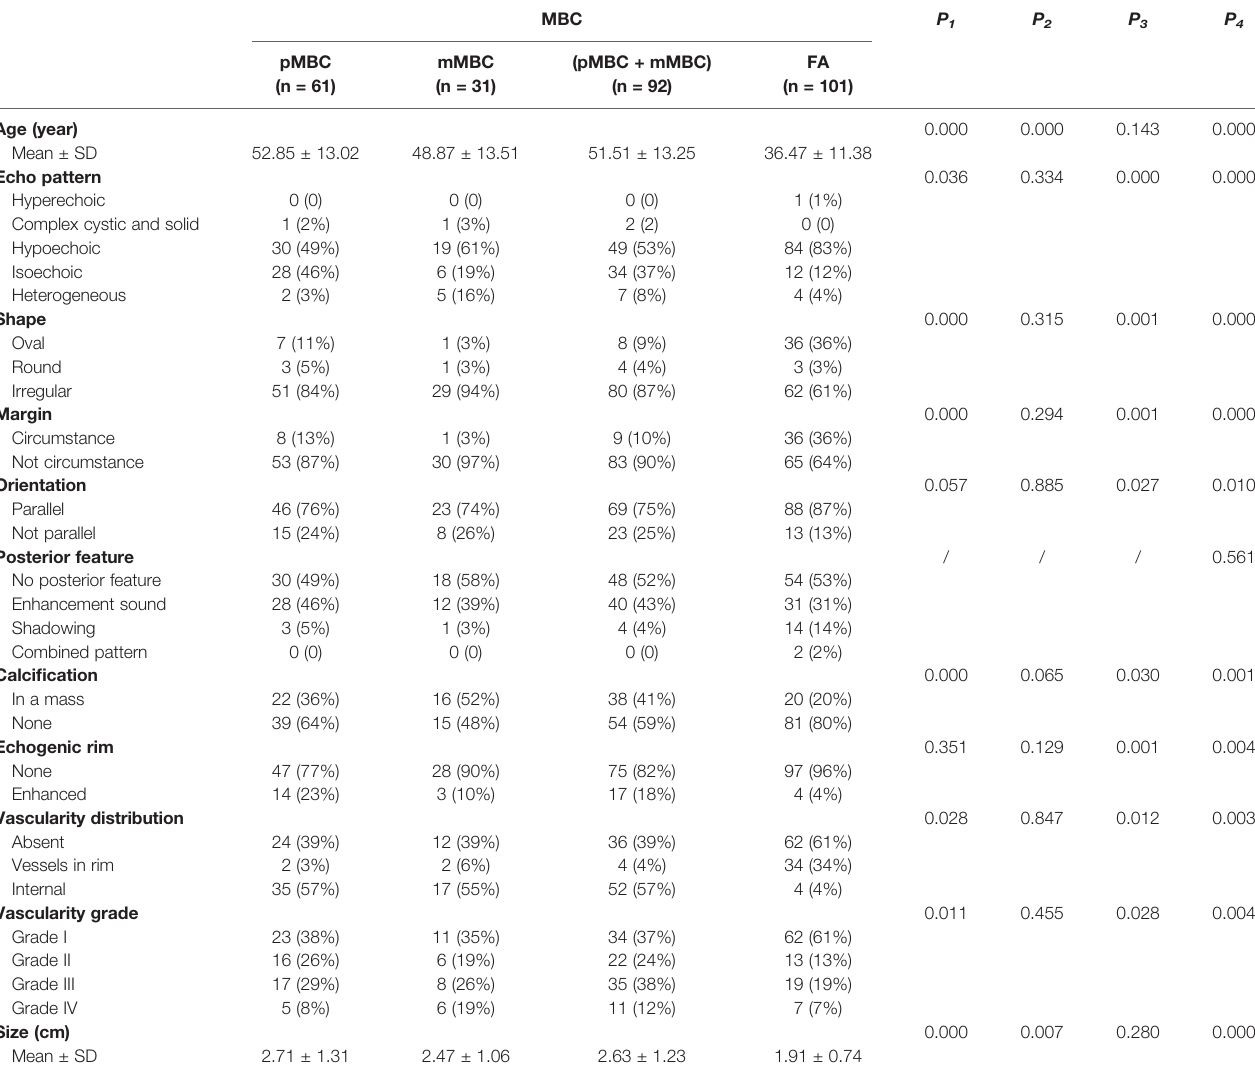
TABLE 1 | Patients ’ age and ultrasonic characteristics in FA, MBC, and